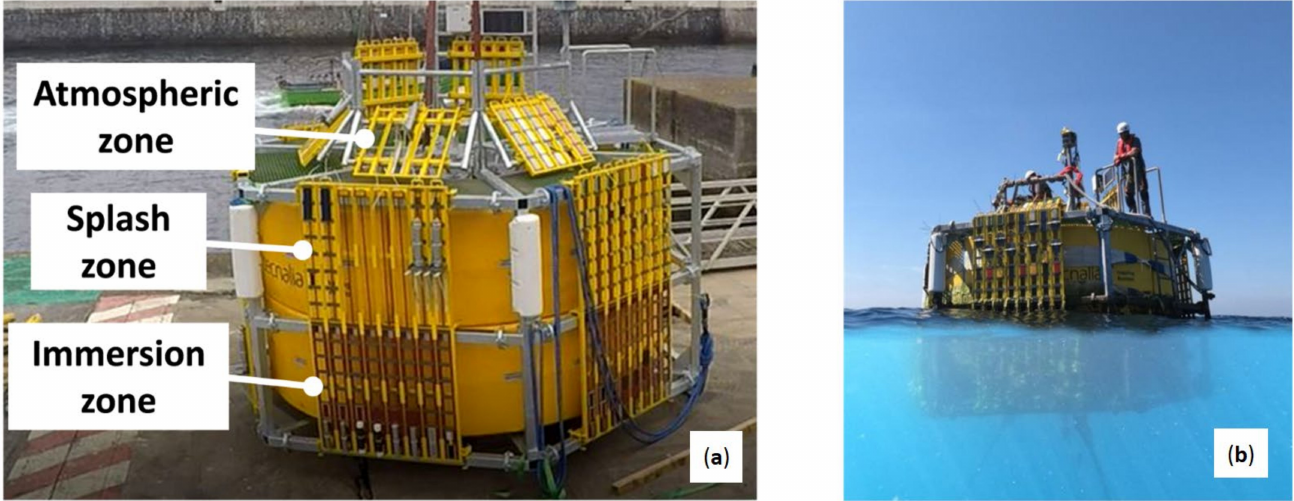
Figure 2. ( a ) The HarshLab 1.0 facility prior to commissioning, prepared to accommodate test panels for field exposure in the atmospheric, splash, and immersion zones. ( b ) The HarshLab moored in the Cantabrian Sea.